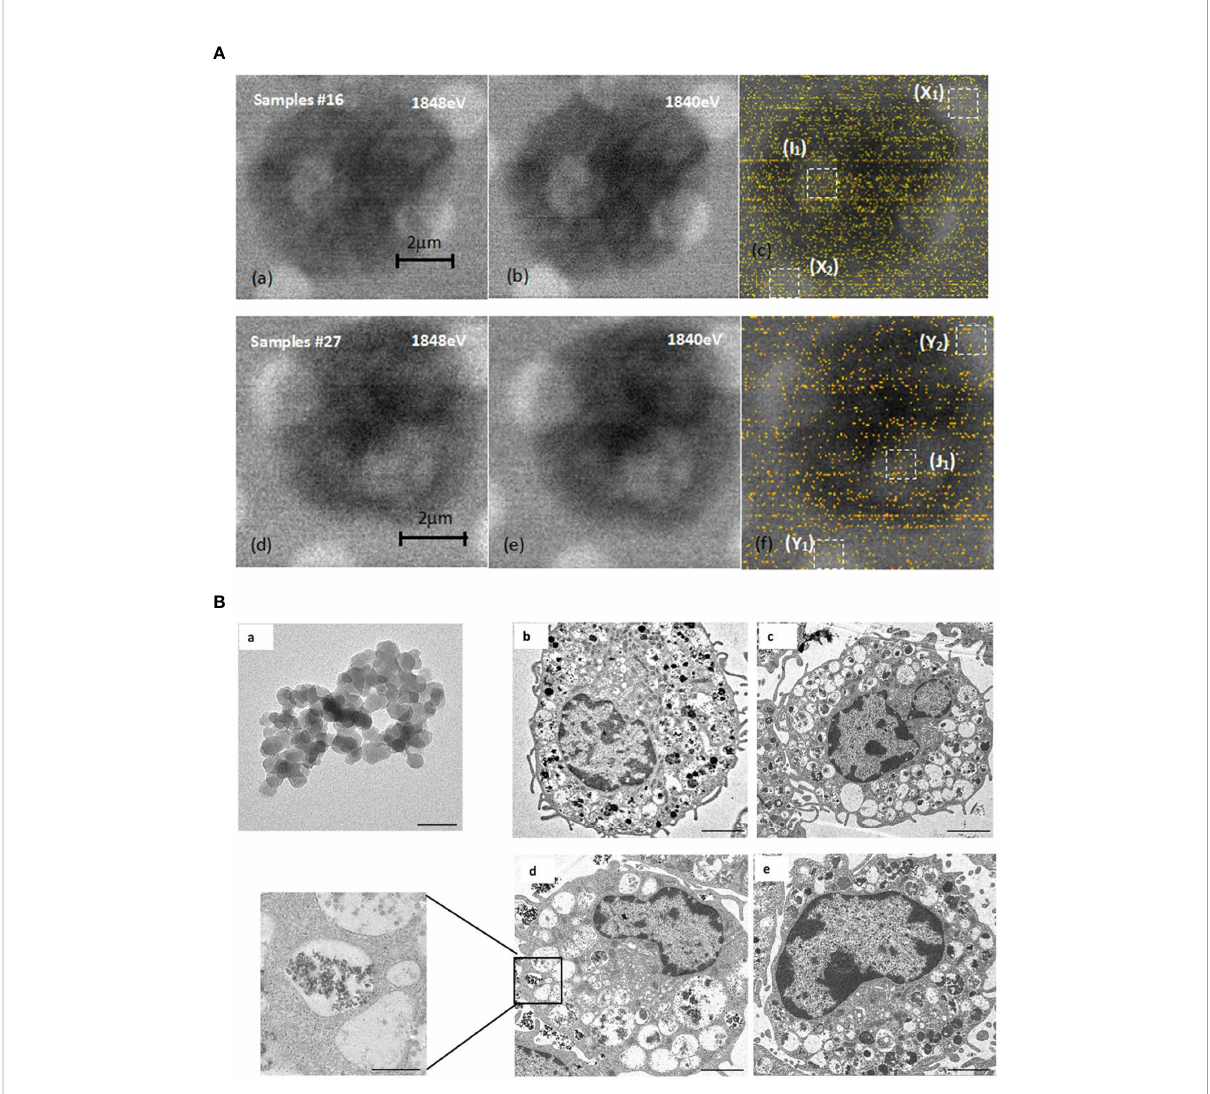
FIGURE 6 STXM and TEM analysis. (A) Comparison of dual-energy imaging between cells (samples #16) loaded with SiO 2 nanoparticles, images shown in (a) , (b) , (c) , and empty cells (sample #27), with the images shown in (d, e, f) . (B) SiO 2 promoted mast cell degranulation. (a) . Transmission electron microscope image of 20 nm SiO 2 (×1000 k, bar=50 nm). (b – e) . Representative transmission electron microscope images of mast cells. b: Blank group (×2.5 k, bar=2 m m); c: DNP-HSA group (×2.0 k, bar=2 m m); d: DNP-HSA+SiO 2 group (×2.5 k, bar=2 m m; ×10 k, bar=500 nm); e: SiO 2 group (×3.0 k, bar=2 m